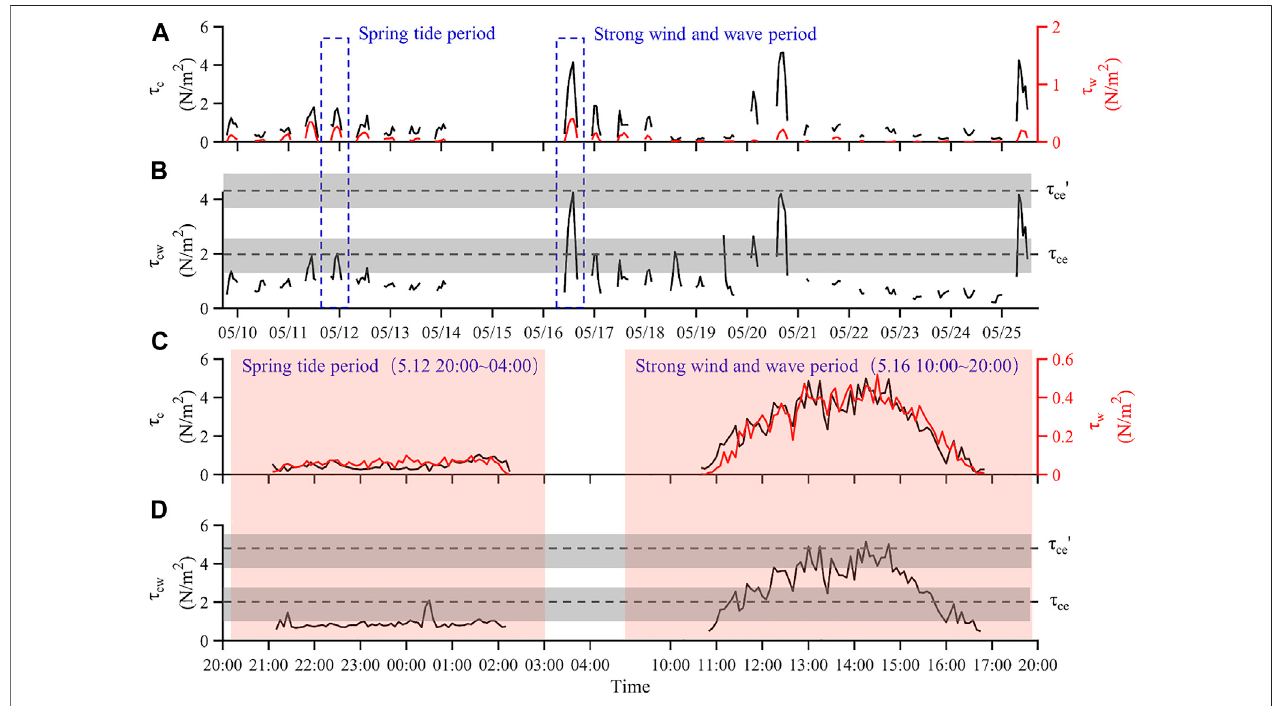
FIGURE 10 | Time series of bed shear stress and critical erosion shear stress of substrate. (A) and (B) show the time series of wave-induced shear stress τ w , current-induced shear stress τ c, and wave-current combined shear stress τ cw throughout the whole observation period, (C) and (D) show the time series of wave- induced shear stress τ w , current-induced shear stress τ c , and wave-current combined shear stress τ cw during the spring tides and strong winds, respectively. τ ce and τ ′ are the average values of the critical erosion shear stresses of the smooth fl at and hummocky patches, and the gray strips are the range of τ ce